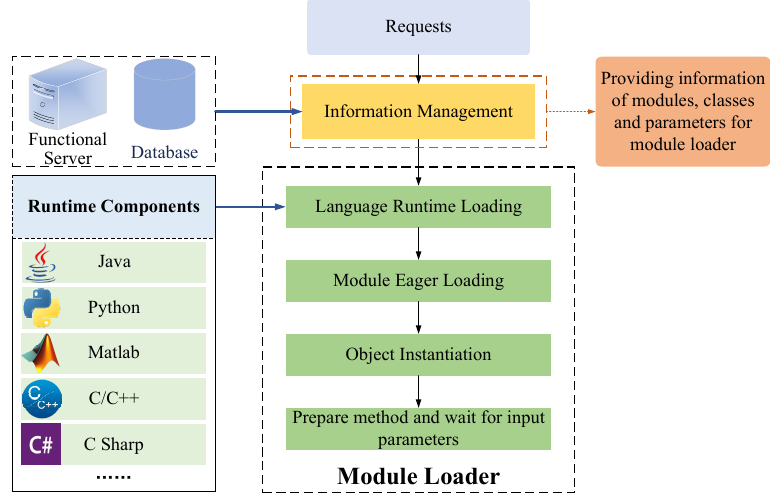
Figure 8. Work flow of Module Loader . The runtime components include di ff erent language running environments.